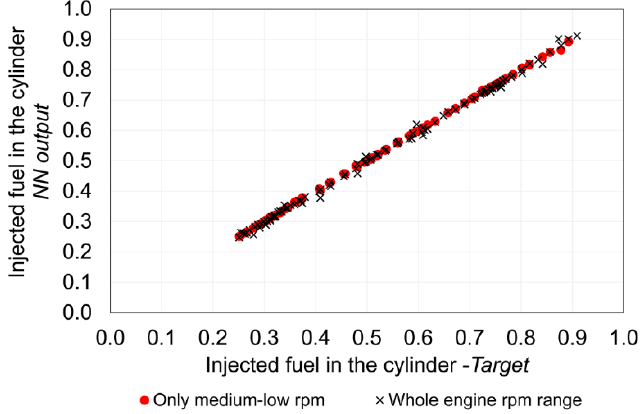
Figure 14. Injected fuel quantity in one cylinder. Comparison between target data and NN output data.